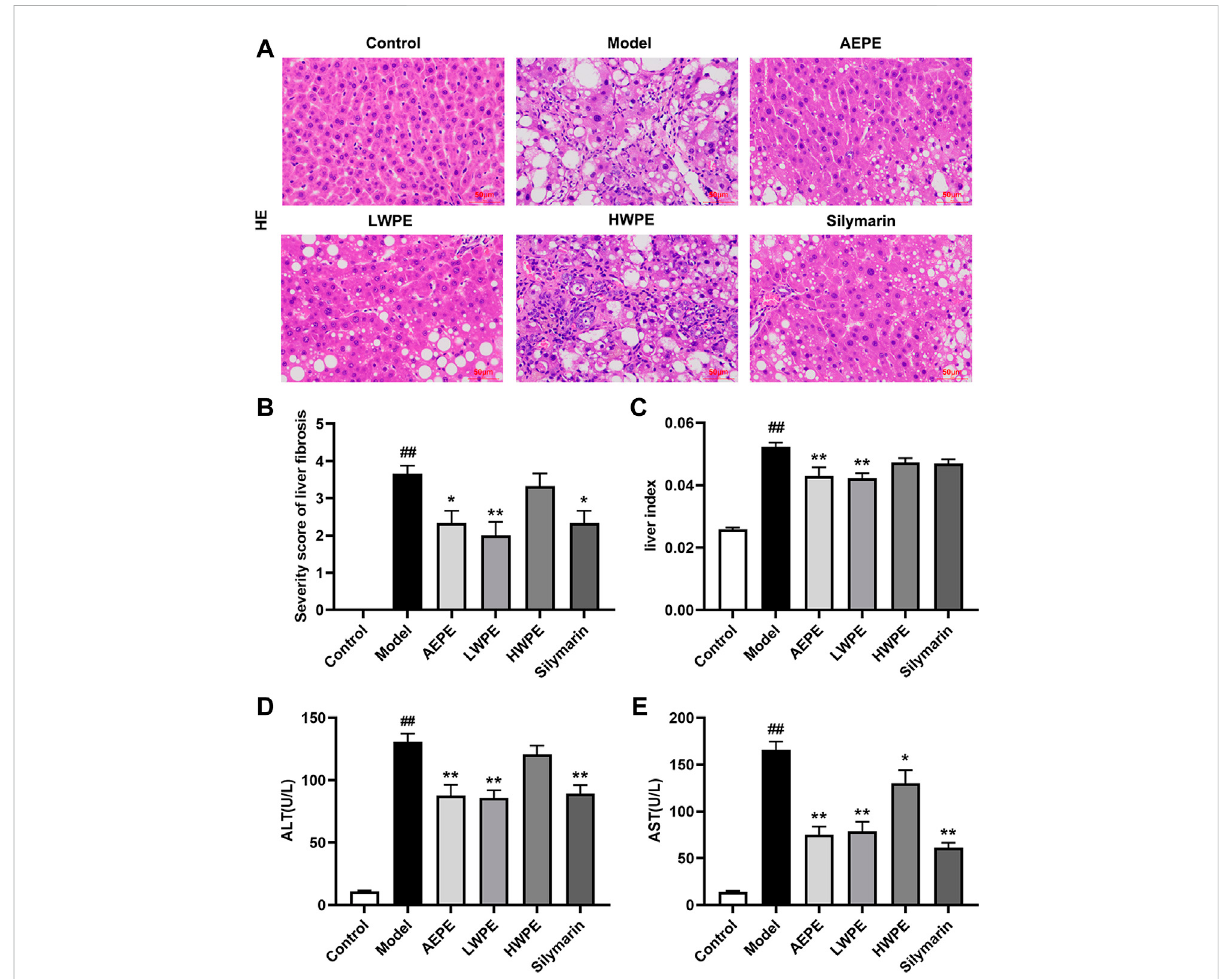
FIGURE 3 Effects of AEPE and its fractions on liver injury in rats administered with CCl 4 . (A) Representative histopathological sections of liver tissue from each group stained with H&E (magni fi cation, ×200). (B) Severity score of hepatic fi brosis in H&E staining. (C) The liver-to-body weight ratio of each rat in the groups was calculated. (D) ALT levels in serum. (E) AST levels in serum. Control, control group. Model, model group. AEPE, aqueous extract of PE group. LWPE, low molecular weight fraction of PE group. HWPE, high molecular weight fraction of PE group. Silymarin, silymarin group. Data are expressed as the mean ± SEM ( n = 7 – 10). ## p < 0.01 vs the control group; * p < 0.05, ** p < 0.01 vs the model